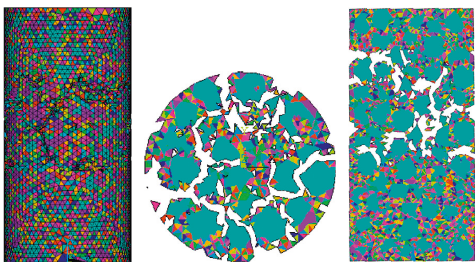
Figure 3: The damagedspecimen and damagedcross sectionof Pre-3.